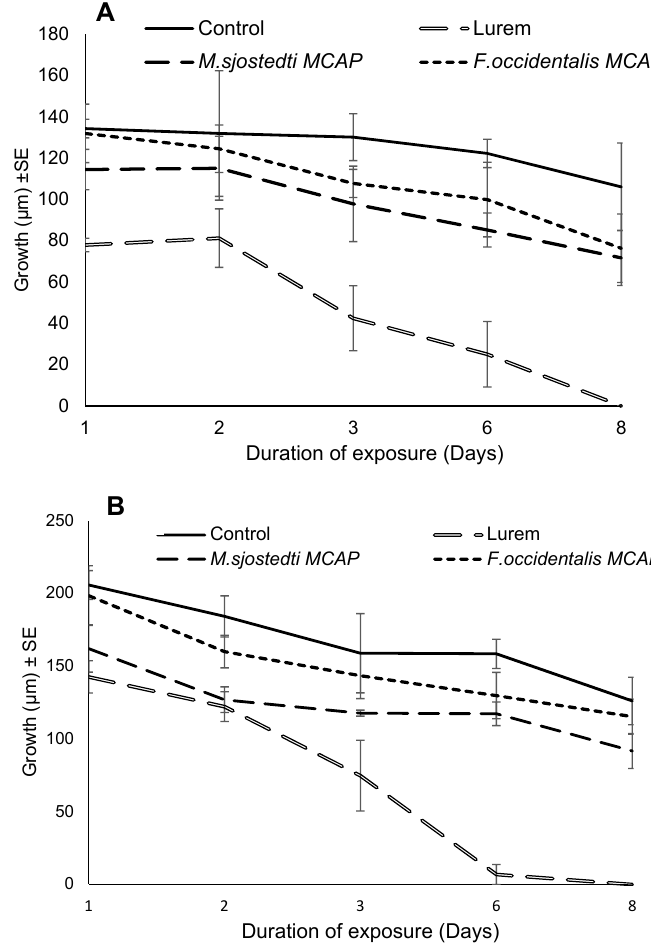
Figure 2. Effect of thrips aggregation pheromones and non-pheromone attractant on M. anisopliae germ tube growth (µm/day) after 0 to 8 days of exposure at 18 h ( A ) and 24 h ( B ) incubation times at 30 µg dose per attractant. MCAP: major component of aggregation pheromones.